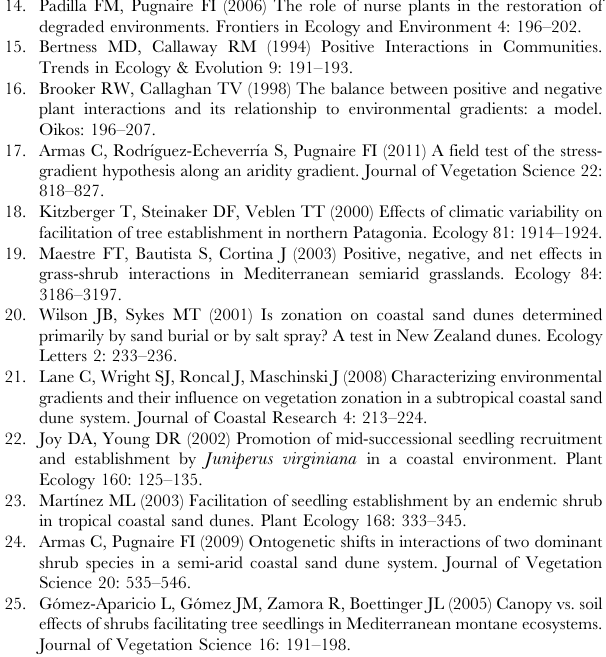
Table S3 Results of random component model